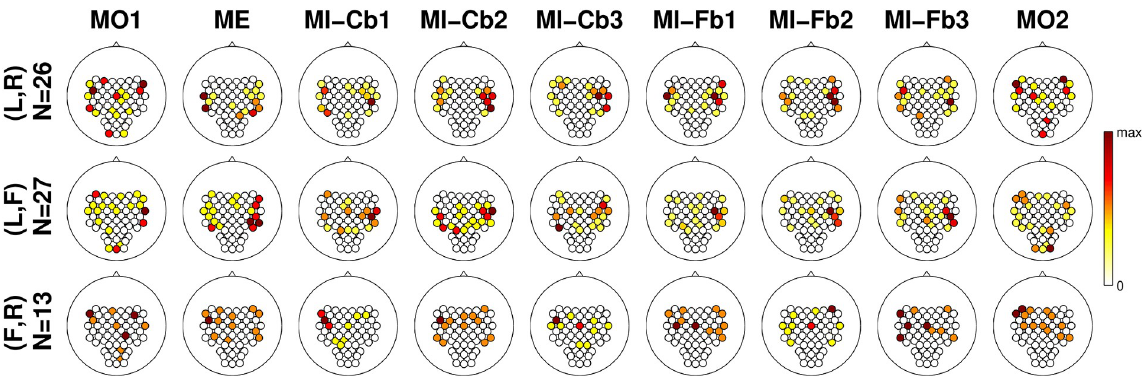
Fig 9. Frequency of selection of the channels as SMR-channel . The number of users for whom each channel was selected is color coded (white for zero, red for the maximum times of selection). From top to bottom, the three class combinations, from left to right, the nine runs.